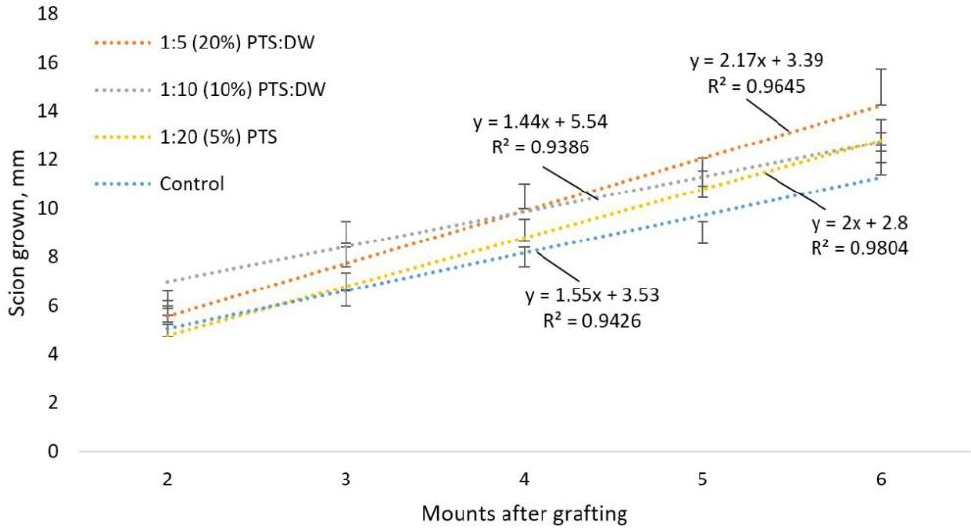
Figure 11. The results of measuring the diameters of the root necks of cherry seedlings of the “Revna” variety within 4 months after planting in the greenhouse with indirect processing using PTS diluted in DW in three proportions (1:5 (20%), 1:10 (10%) and 1:20 (5%)). The most significant value for the growth of fresh shoots was obtained with the exposure of the inoculated components to CAP for 15 s, with the growth rate of the control samples exceeded by 17%; when exposed for 30 s, the growth of shoots was slightly lower than the control ( − 6.5%); however, when monitoring the development of seedlings in